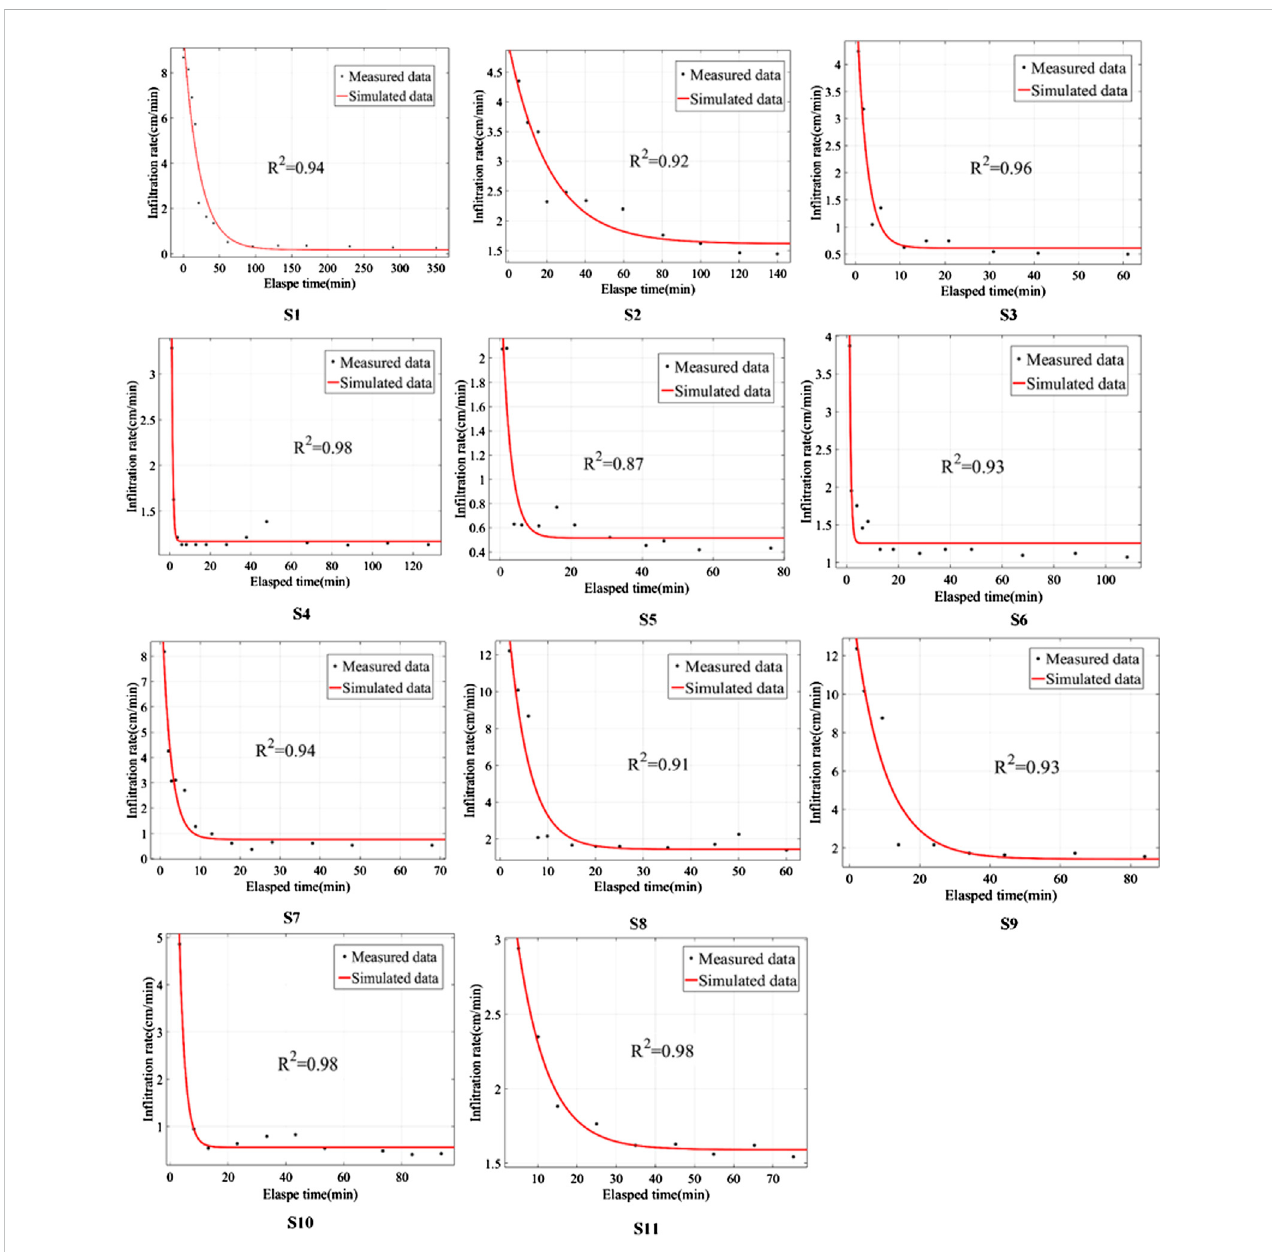
FIGURE 5 The Horton in fi ltration